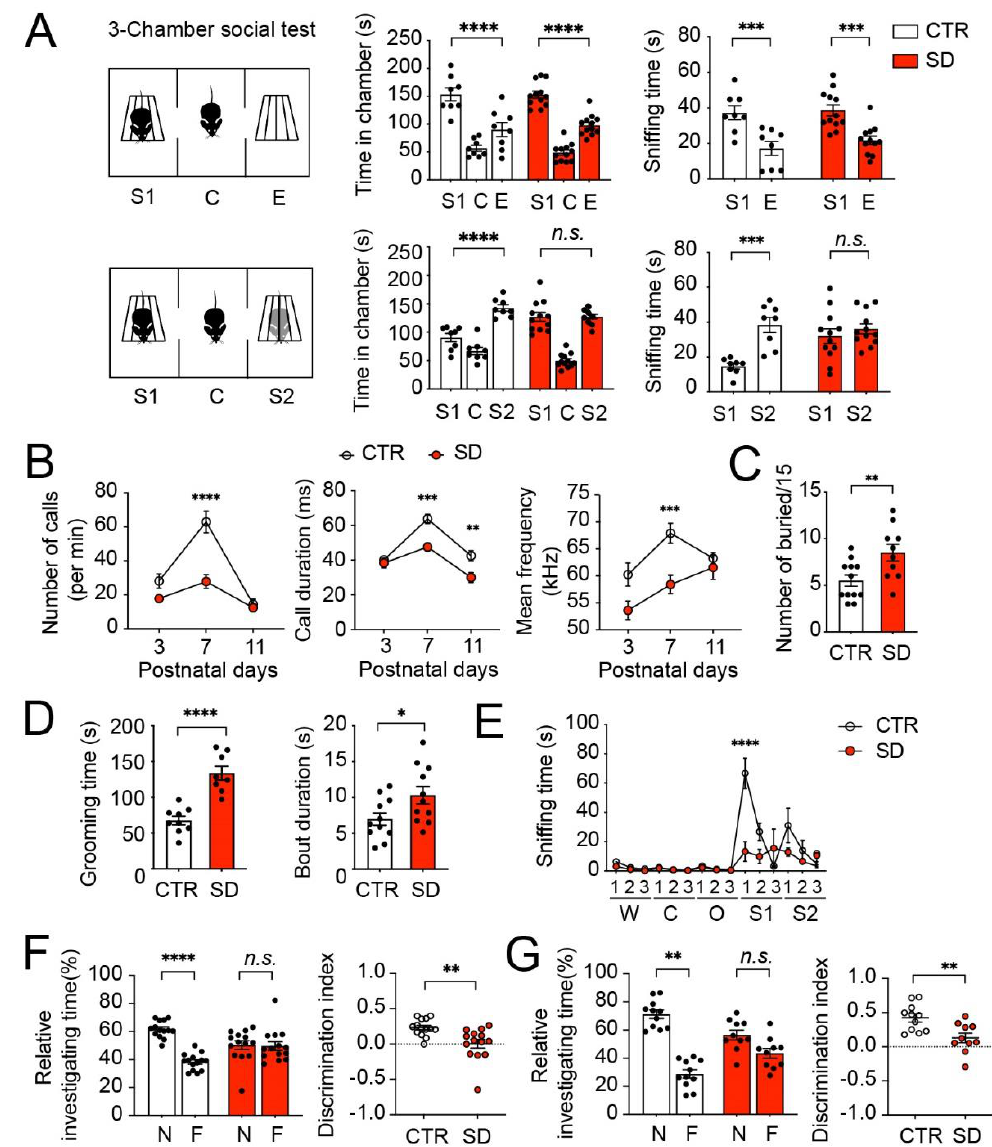
Figure 6. Autistic-like behavioral changes in SD mice. ( A ) Three-chamber test for mouse sociability. Left: a schematic diagram. S1: stranger 1; C: center; E: empty; S2: stranger 2. Right: bar graphs indicating time spent in individual chambers and time spent sniffing wire cages during the three-chamber test. Note that both CTR and SD mice spent longer times in the S1 chamber and sniffing the S1 cage, compared with in the E chamber and sniffing the E cage. CTR mice spent longer times in the S2 chamber and sniffing the S2 cage, compared with in the S1 chamber and sniffing the S1 cage. In contrast, SD mice spent similar times in the S1 and S2 chamber and sniffing the S1 and S2 cage. Data are displayed as individual values and mean ± SEM. *** p < 0.001; **** p < 0.0001; n.s., not significant. Data are displayed as individual values and mean ± SEM. n = 8 in CTR and n = 12 in SD. ( B ) Ultrasonic vocalization tests at Postnatal Day (P) 3, 7, and 11. Note that SD pups exhibited a reduced number of calls, call durations, and call frequencies at P7 compared with the CTR pups. Data are displayed as mean ± SEM ** p < 0.01; *** p < 0.001; **** p < 0.0001 vs. CTR; n = 5–6 for P3 and P11 in CTR and SD; n = 8-9 for P7 in CTR and SD. ( C ) A bar graph indicates the numbers of marbles buried in the marble burying test. n = 12 in CTR and n = 10 in SD. Data are displayed as individual values and mean ± SEM. ** p < 0.01. ( D ) Spontaneous self-grooming test. Note that SD (n = 8) mice displayed increased grooming time and duration of bouts as compared with WT (n = 9) mice. * p <0.05; **** p < 0.0001 vs. CTR ( E ) Olfactory habituation test. W: water; C: cinnamon; O: food (butter); S1: social odor 1 (dirty cage swab1); S2: social odor 2 (dirty cage swab2). Note that time spent sniffing the social odor was markedly reduced, whereas time sniffing nonsocial odors was not changed in the SD mice compared with the CTR mice. **** p < 0.0001 vs. CTR. n = 4 mice in CTR and SD. Data are presented as mean ± SEM. ( F ) Novel object recognition test. During the training session, the